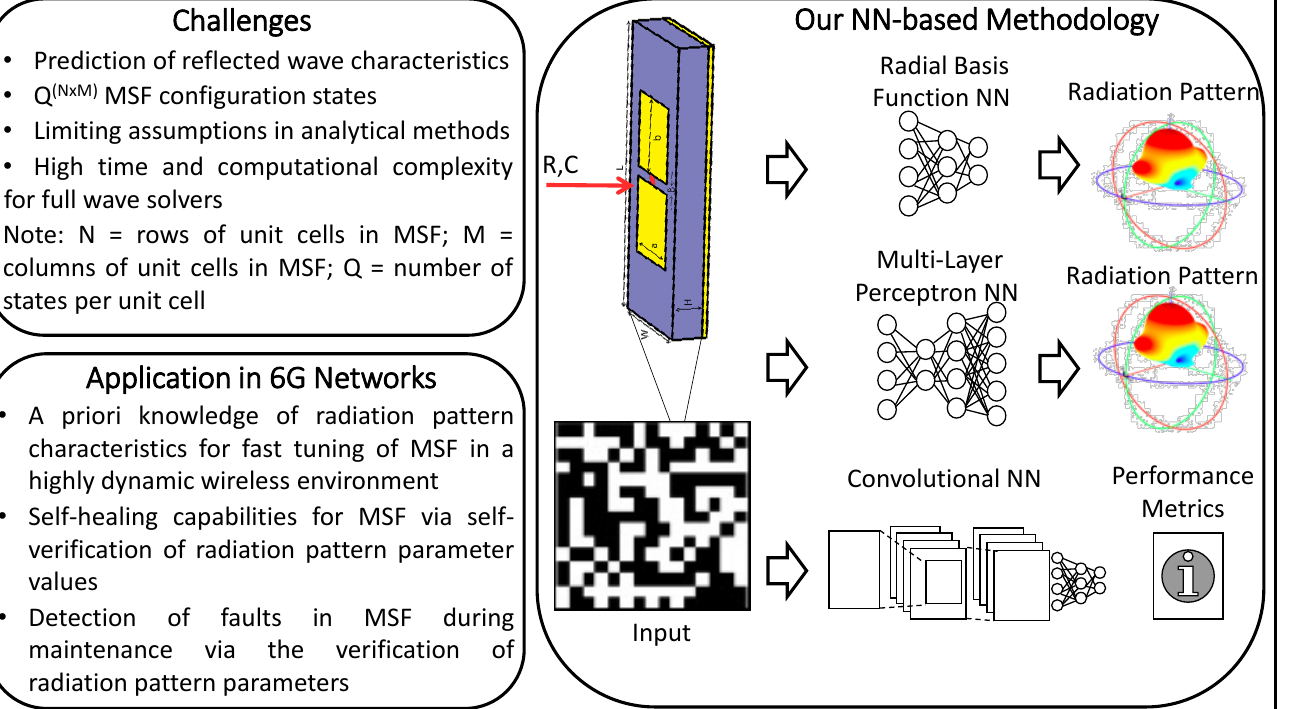
Figure 1. Neural Network-based approach for radiation pattern prediction: Challenges, Methodology and Application.